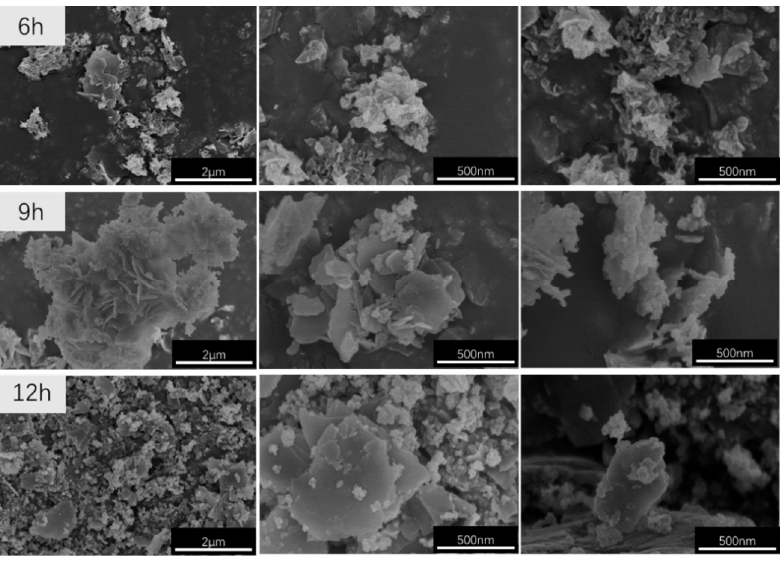
Figure 8. SEM images of CaAl–SiO 3 –LDHs samples prepared at different crystallisation